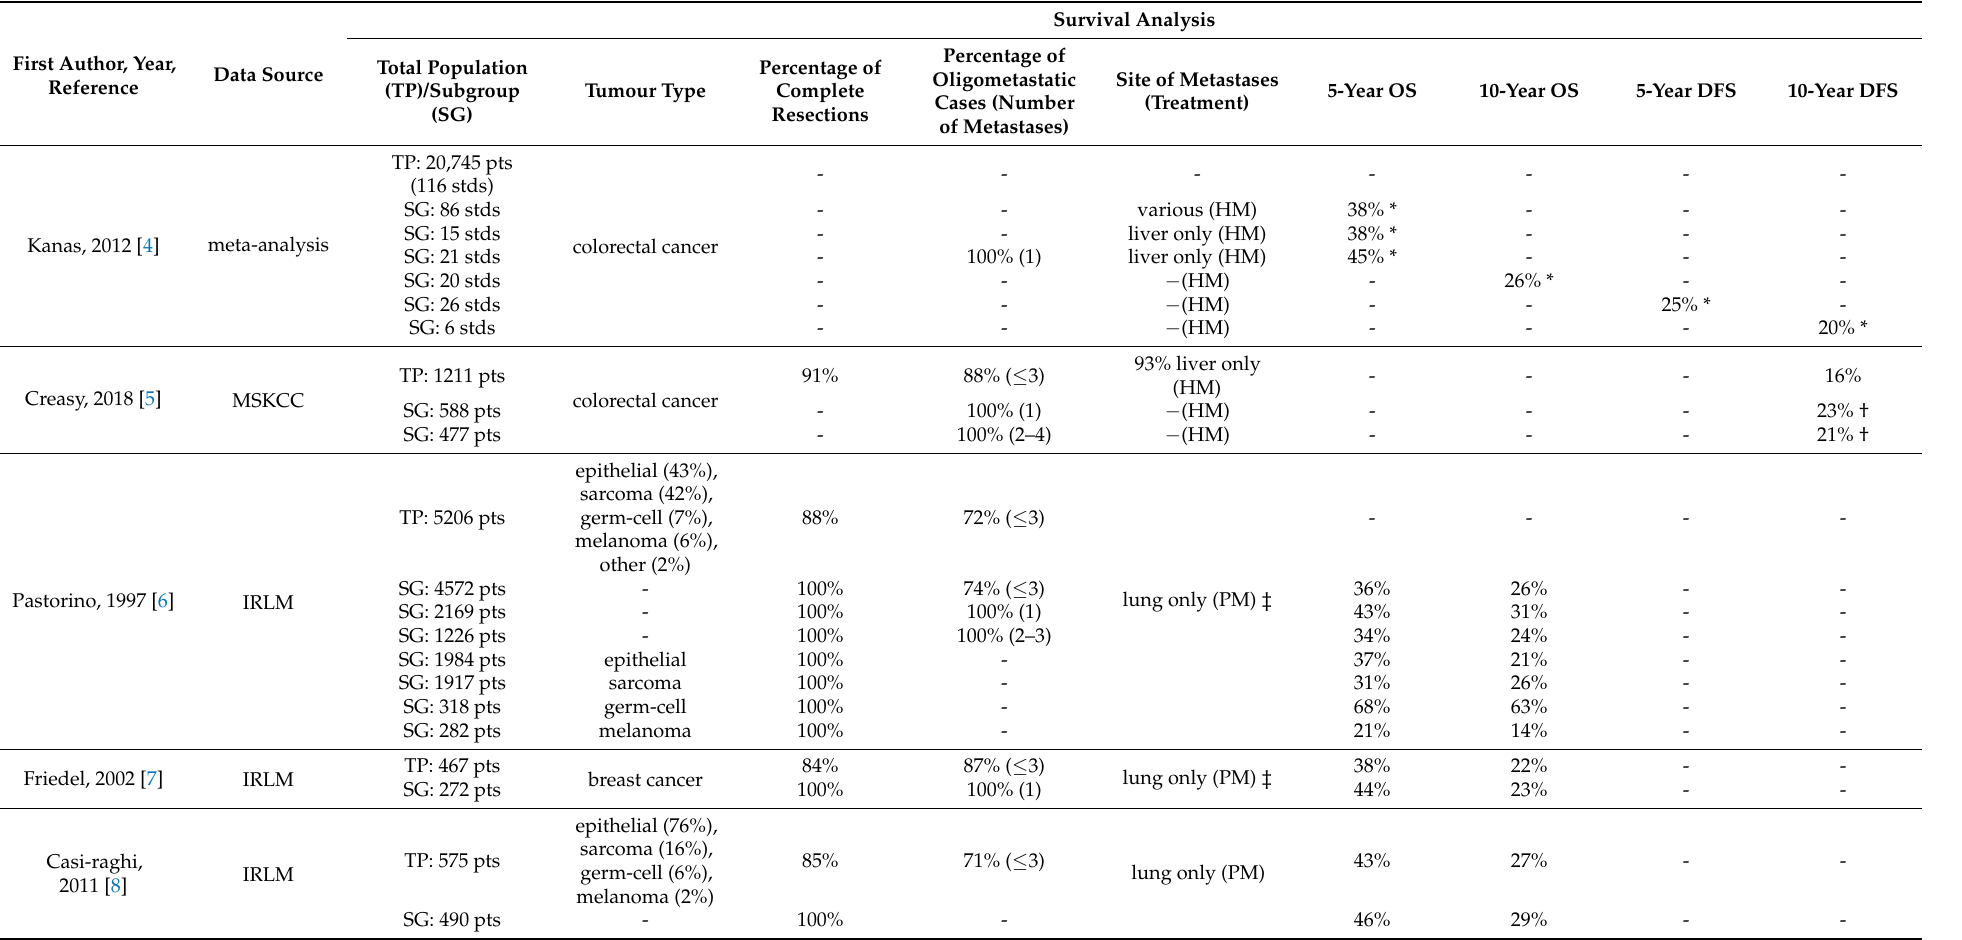
Table 1. Long-term survival outcomes in patients with oligometastatic disease enrolled in large-scale studies or